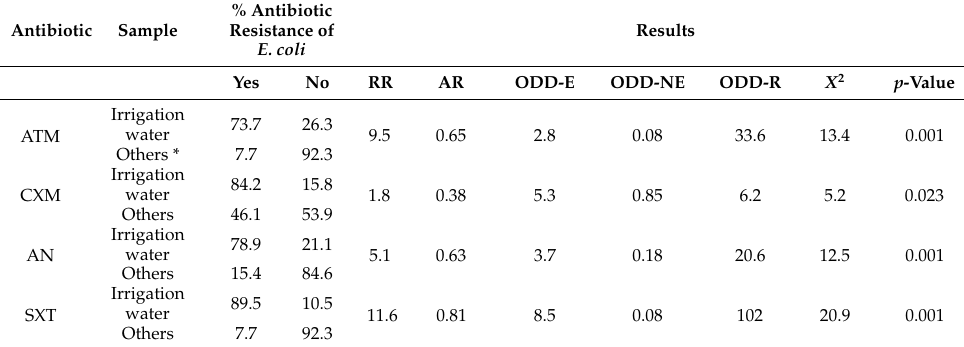
Table 3. E. coli antibiotic resistance inferences based on the sampling